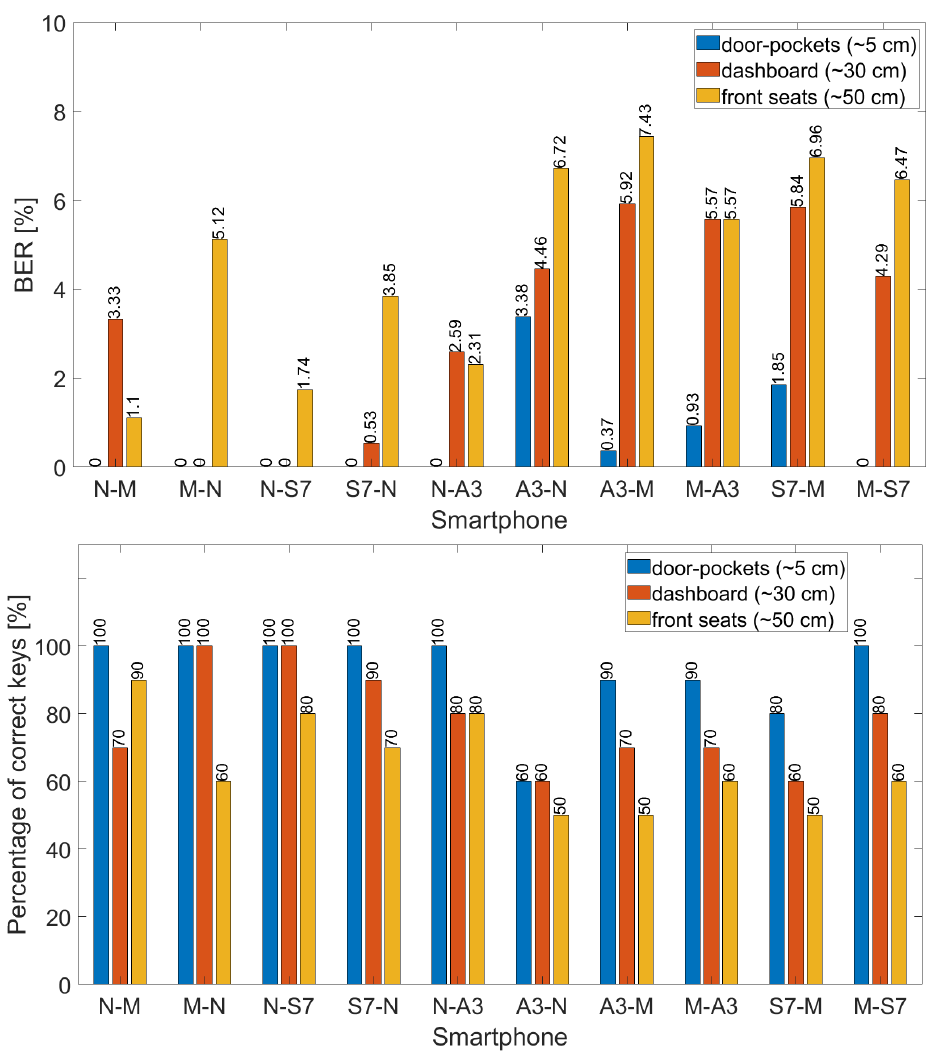
Figure 13. The BER ( up ) and the percentage of correct keys ( down ) for each smartphone pair for in-vehicle experiments with